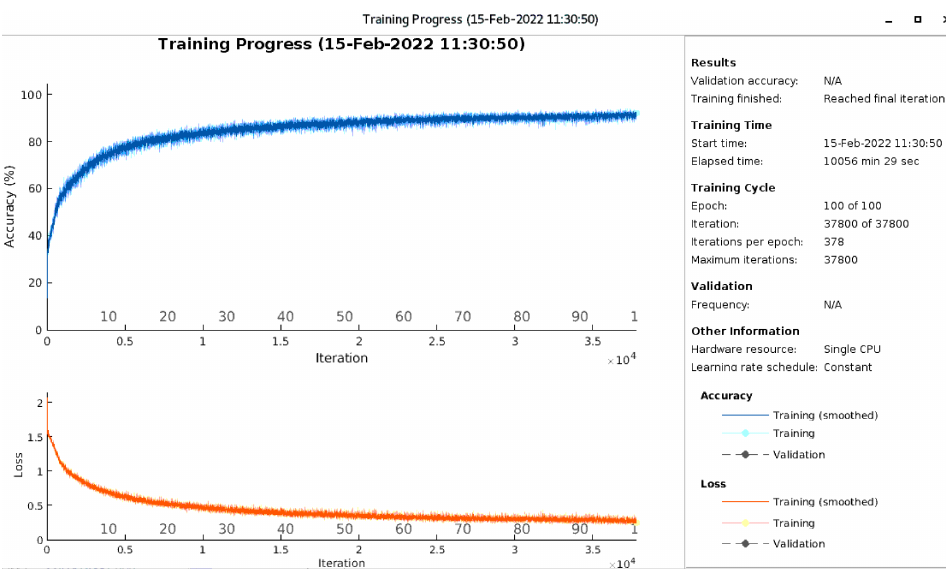
Figure 8. CNN-LSTM training